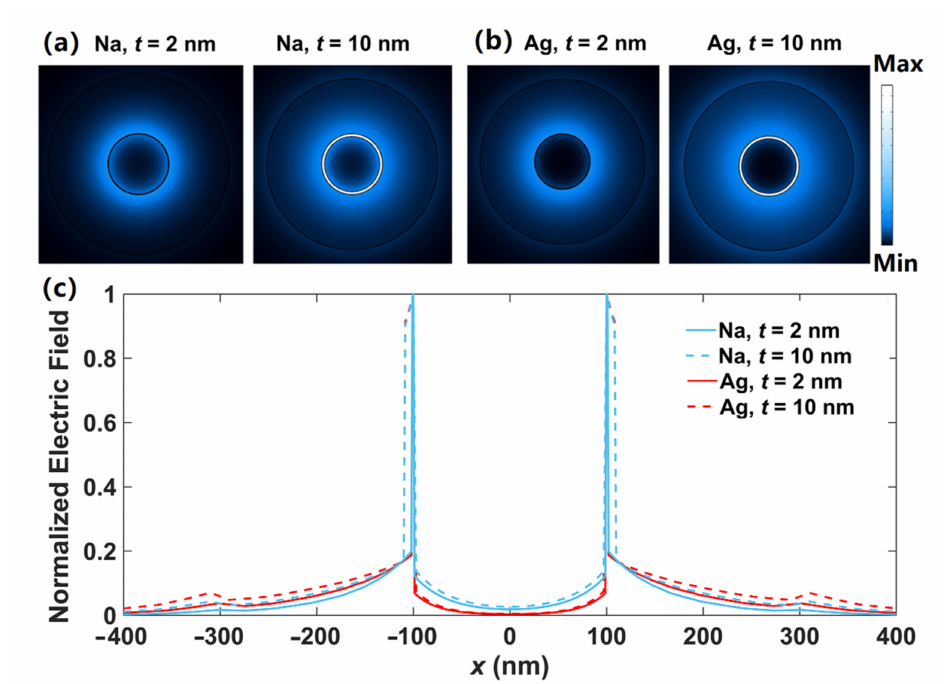
Figure 8. Field distributions of |E| of the fundamental mode in DDCMNWs at λ = 1500 nm for ( a ) Na and ( b ) Ag. ( c ) Field distributions along x